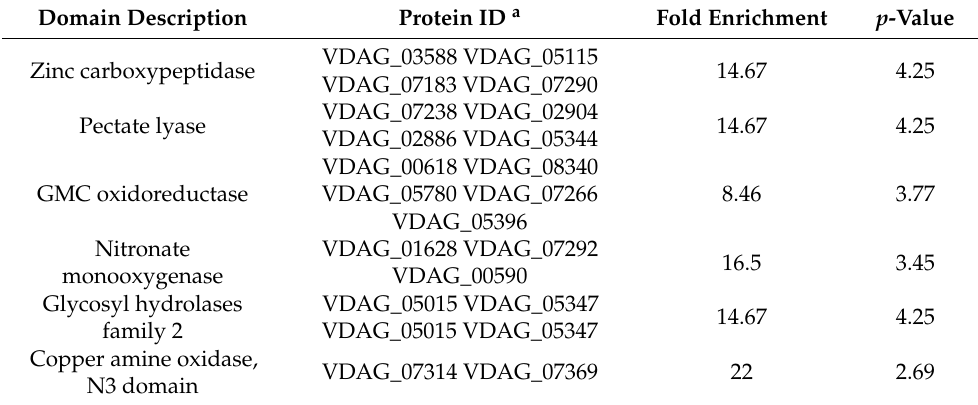
Table 3. List of the proteins whose expression was upregulated in protein domain.